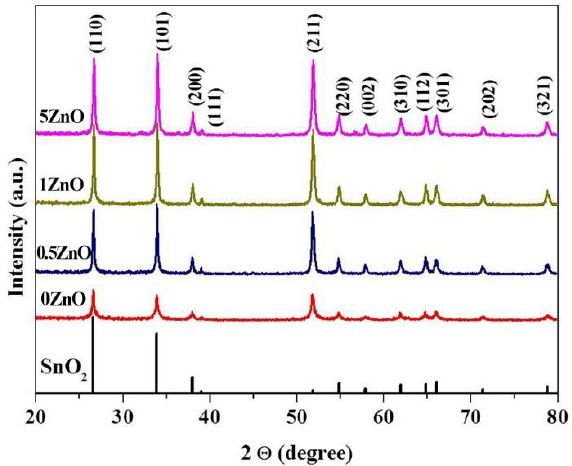
Figure 2. XRD patterns of synthesized film materials 0ZnO, 0.5ZnO, 1ZnO, 5ZnO. The degree of material crystallinity was determined by XRD according to the method described in the paper [49,50]. It was found that an increase in the content of the intro- duced additives leads to an increase in the degree of materials ’ crystallinity (57.2, 66.0, 67.0 and 67.4% for 0ZnO, 0.5ZnO, 1ZnO, and 5ZnO materials, respectively). Cross-sectional and top-view SEM images of 0ZnO (a), 0.5ZnO (c), 1ZnO (e), and